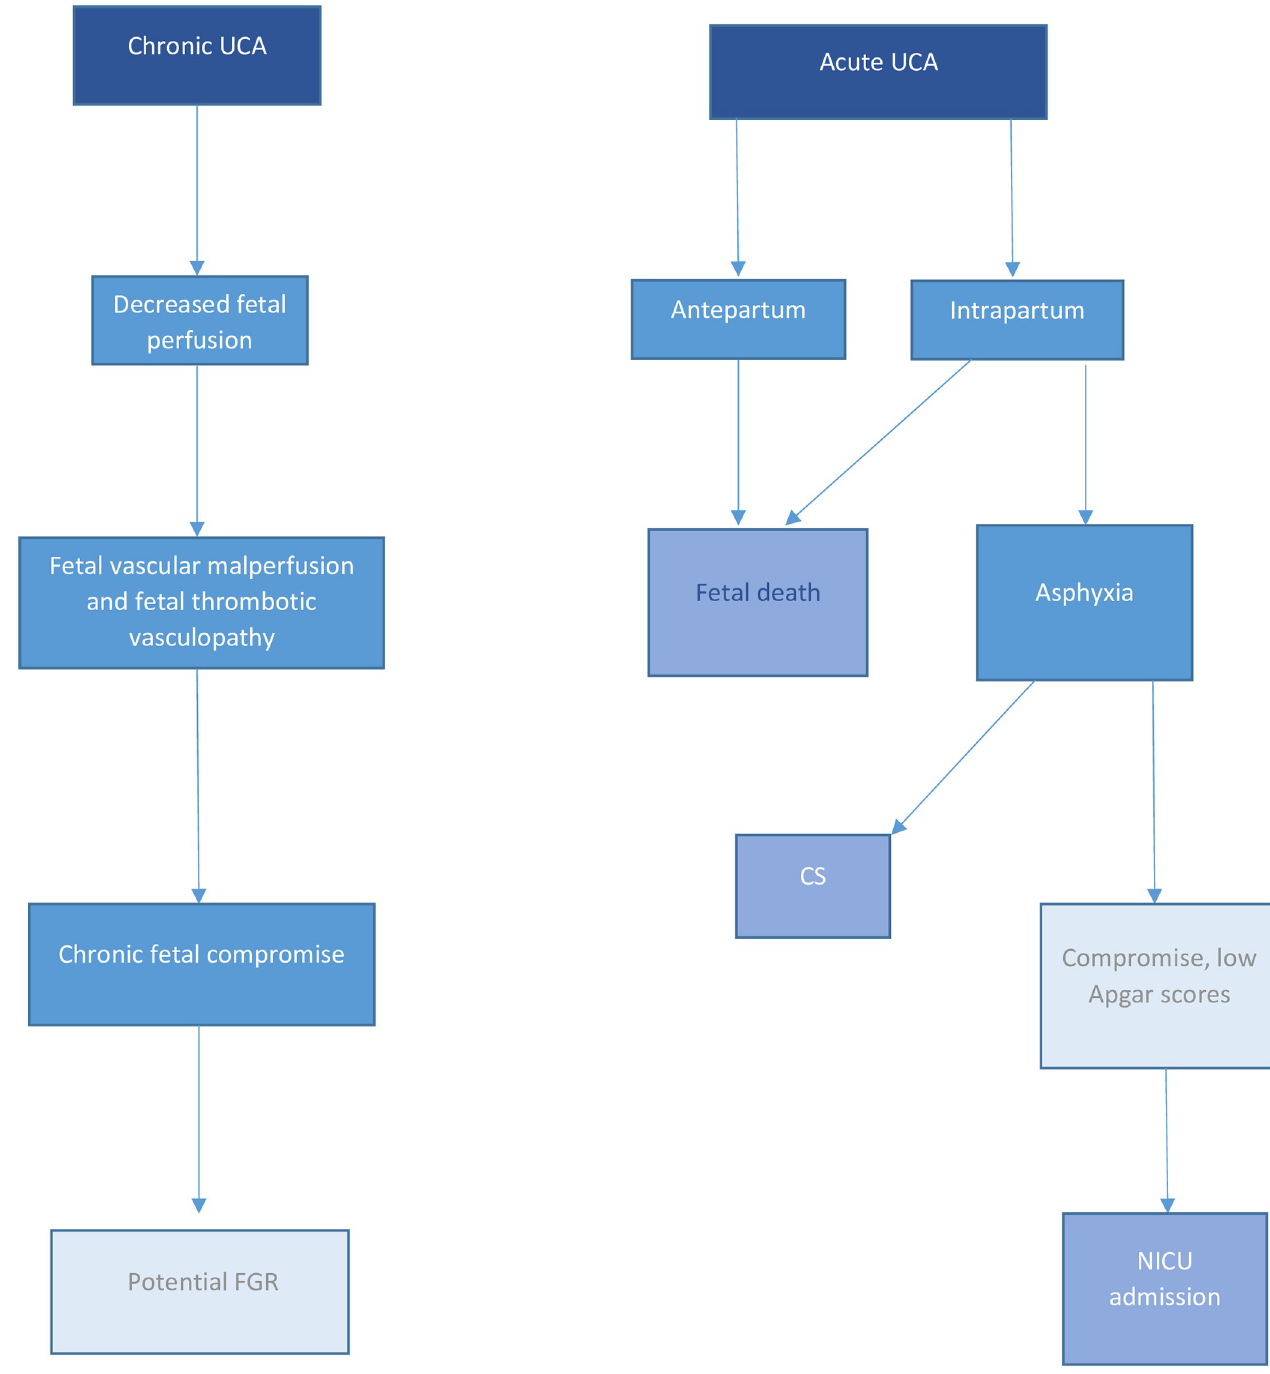
Fig 1. Proposed pathway for potential effects of chronic and acute